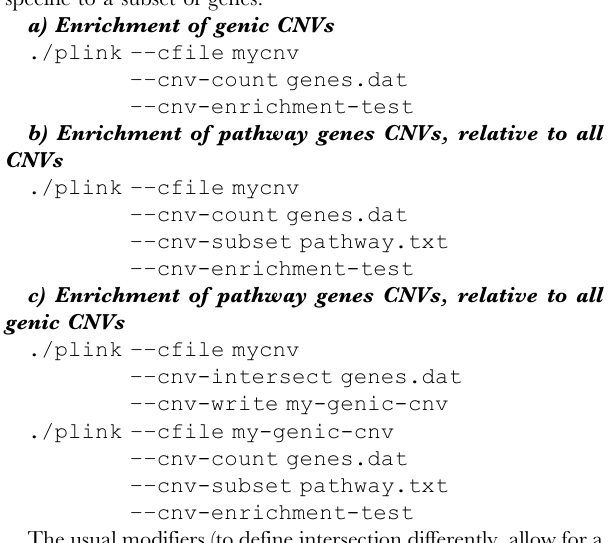
Table S2 Simulated distribution of CNV rate and size in cases and controls. We tested different statistical models as outlined in Materials and Methods (M0–M4) for false positive associations under each of five extreme scenarios (S0–S4) outlined in the above table. For a single hypothetical chromosome, 250Mb in length, we